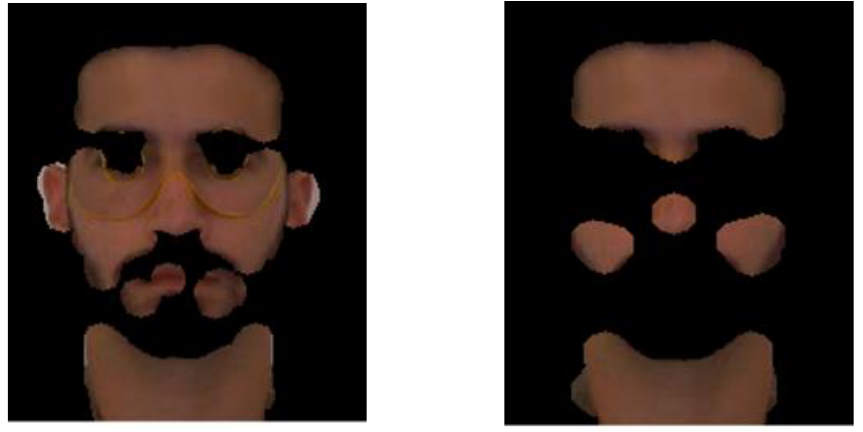
Figure 6. Results obtained with YCbCr ( left ) and HSV ( right ) classifiers.